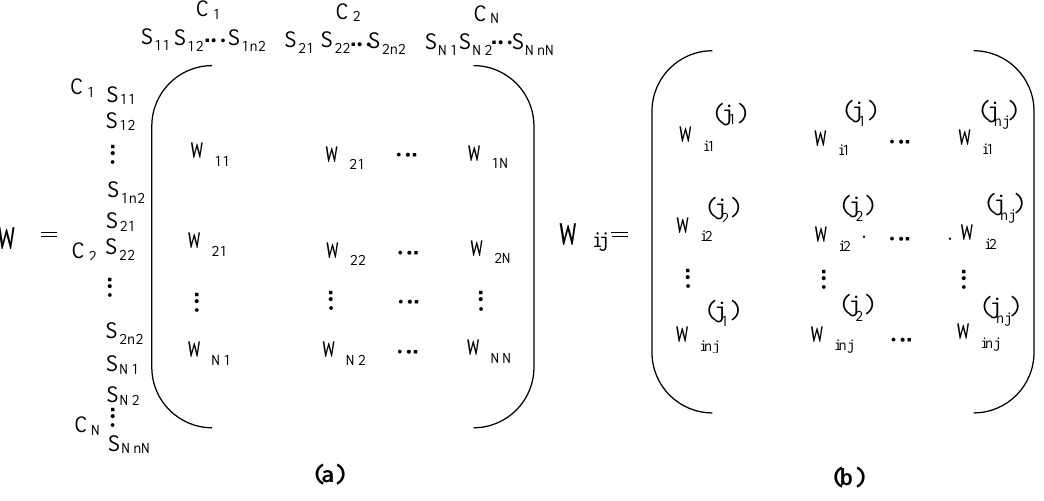
Figure 3. ANP entry-matrices: ( a ) the network supermatrix, ( b ) the network sub-matrix [19].